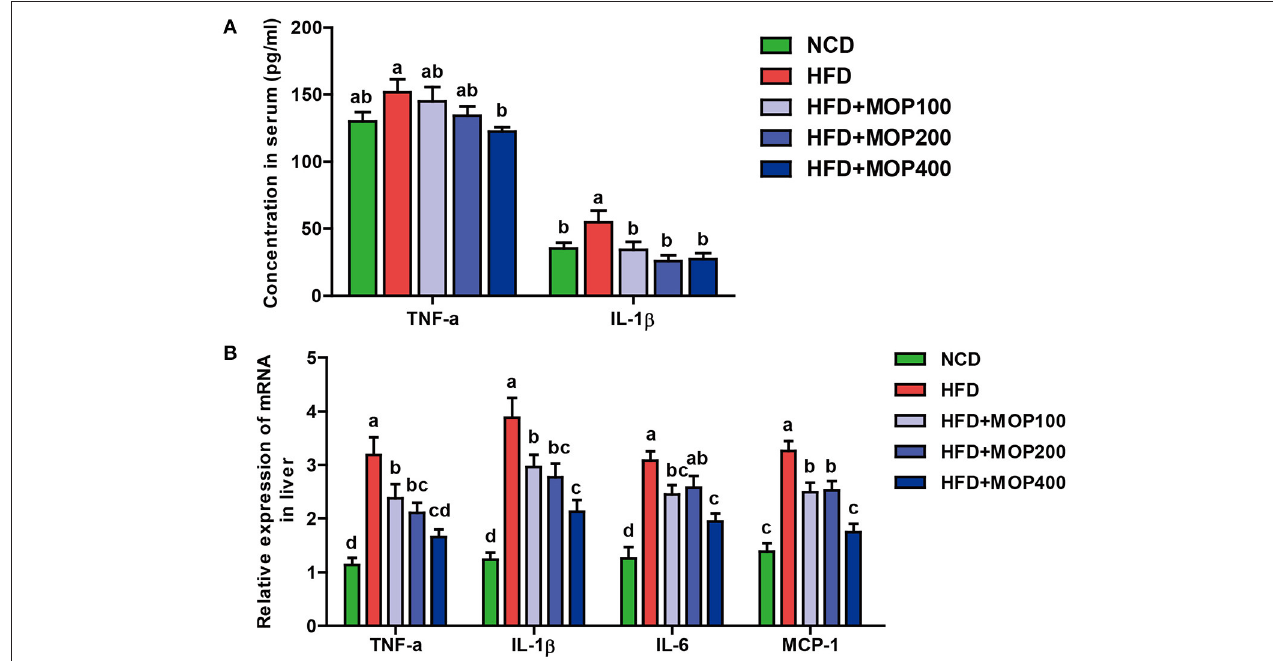
FIGURE 4 | MOP alleviates the production of pro-inflammatory cytokines in HFD-fed mice. (A) Serum protein levels of TNF- α and IL-1 β were determined by ELISA ( n = 8 mice/group); (B) Relative mRNA expression levels of TNF- α , IL-1 β , IL-6, and monocyte chemotactic protein-1 (MCP-1) in the liver as determined by qRT-PCR ( n = 6). Bars marked with different superscript letters (a-d) indicate significant differences at p < 0.05 based on one-way ANOVA with Duncan’s post-hoc